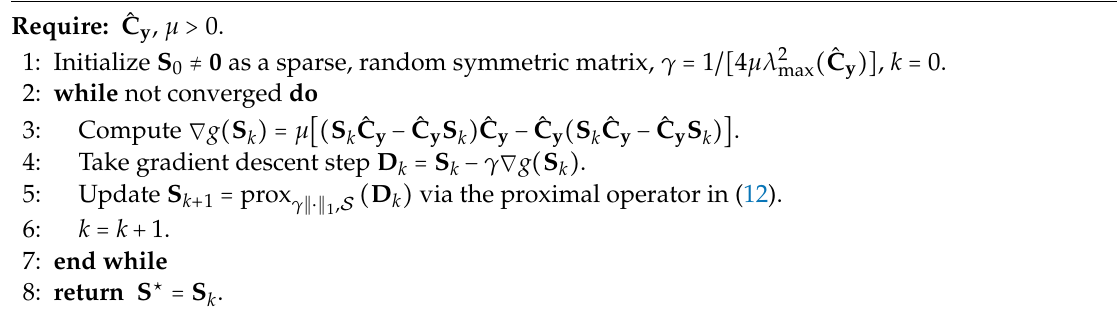
Algorithm 1 Proximal gradient (PG) for batch topology